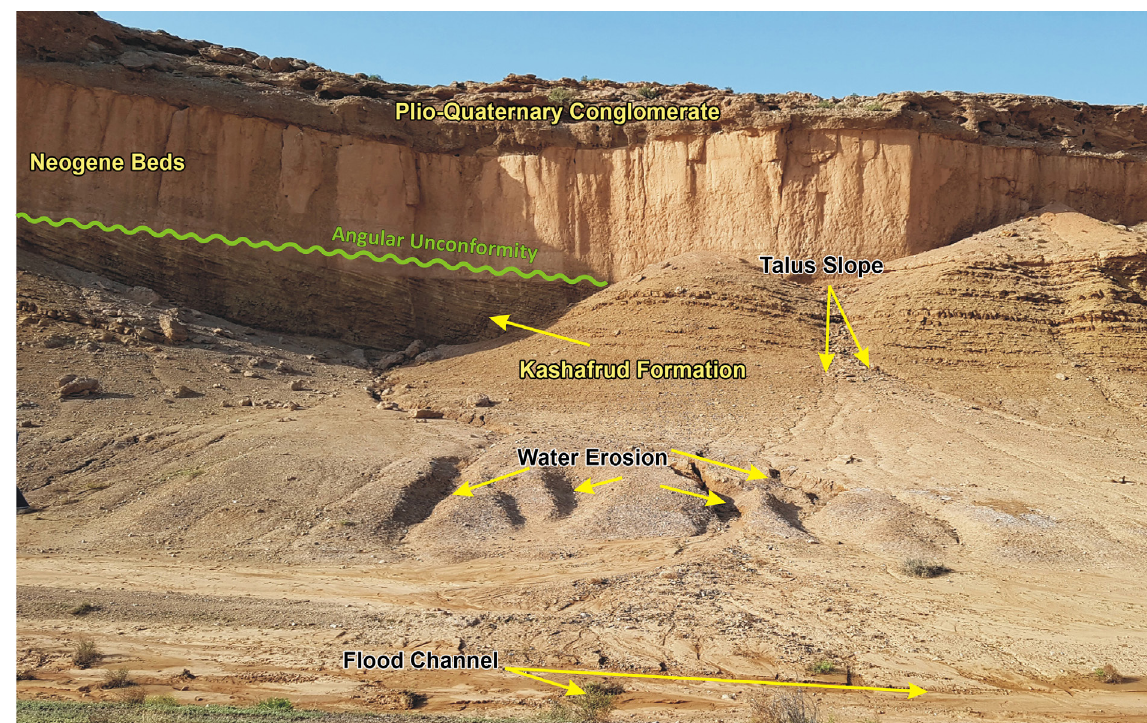
Figure 12. Geodiversity and Nonequilibrium in the Kashafrud Formation, Neogene beds, and Plio-Quaternary rocks in the south of Mozduran Pass, Mashhad-Sarakhs Road (Photo by author 1401)